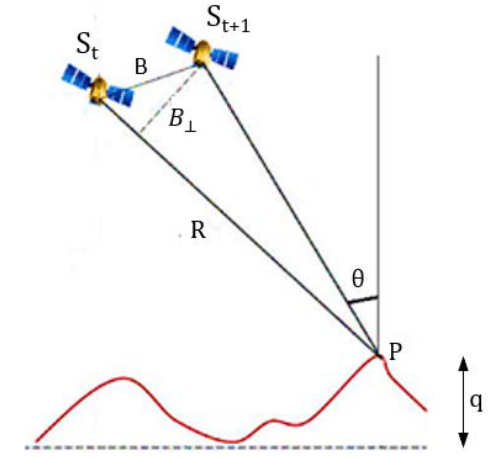
Figure 2. Geometry of an interferometric SAR system. The target P is imaged by radar S at different